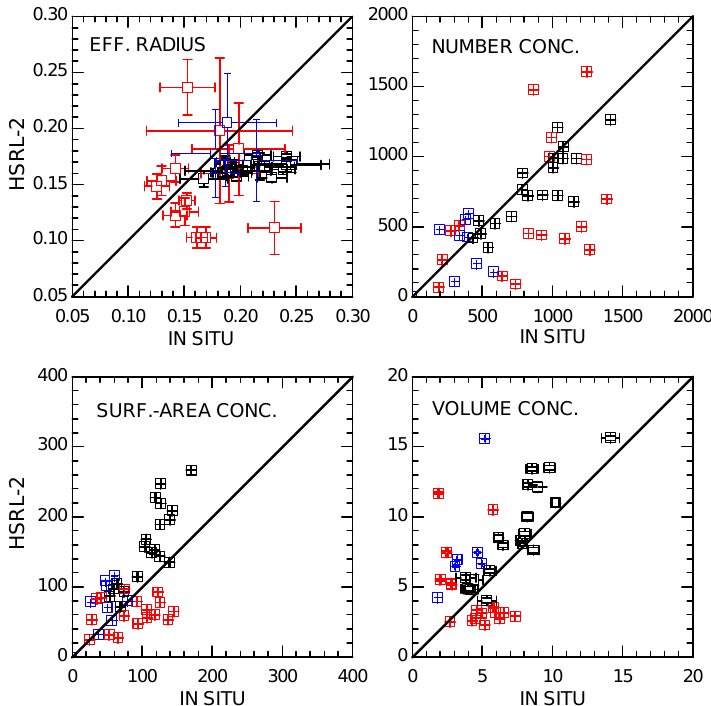
Figure 6. Correlation between inversion results and in situ results for effective radius, number concentration (1/cm), surface-area concentra- tion (µm 2 cm − 3 ), and volume concentration (µm 3 cm − 3 ) on 17 July (black), 22 July (red), and 25 July (blue). Error bars denote 1 standard deviation and describe the variation of the data points in the 150m thick layers that were used in the data inversion. Each data point has its own uncertainties, and it follows from the measurement uncertainties (in situ) and data inversion errors. The average uncertainty of each of the four data products is mentioned in the text. Effective radius uncertainties are propagated from volume and surface-area uncertainties without taking potential correlation into account, and therefore may be overestimated. The three data points of the in situ measurements shown in Fig. 5 (effective radius above 0.31µm) are not shown in this